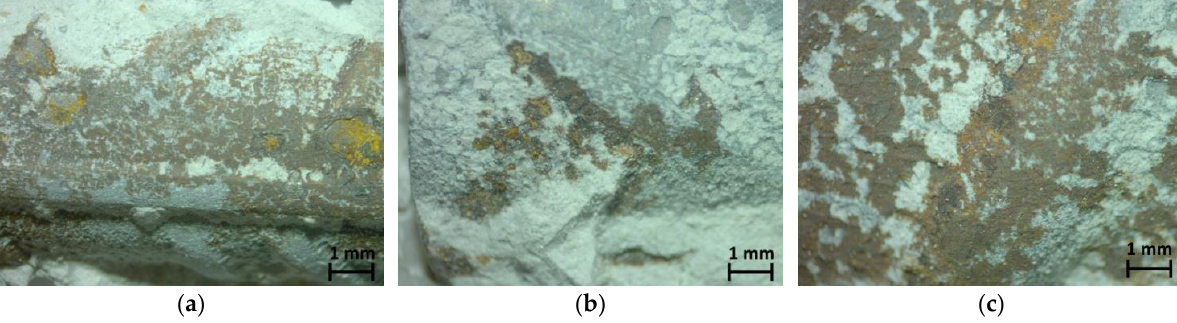
Figure 8. Stereoscopy images: ( a ) RM, ( b ) HDPE, ( c ) PP.